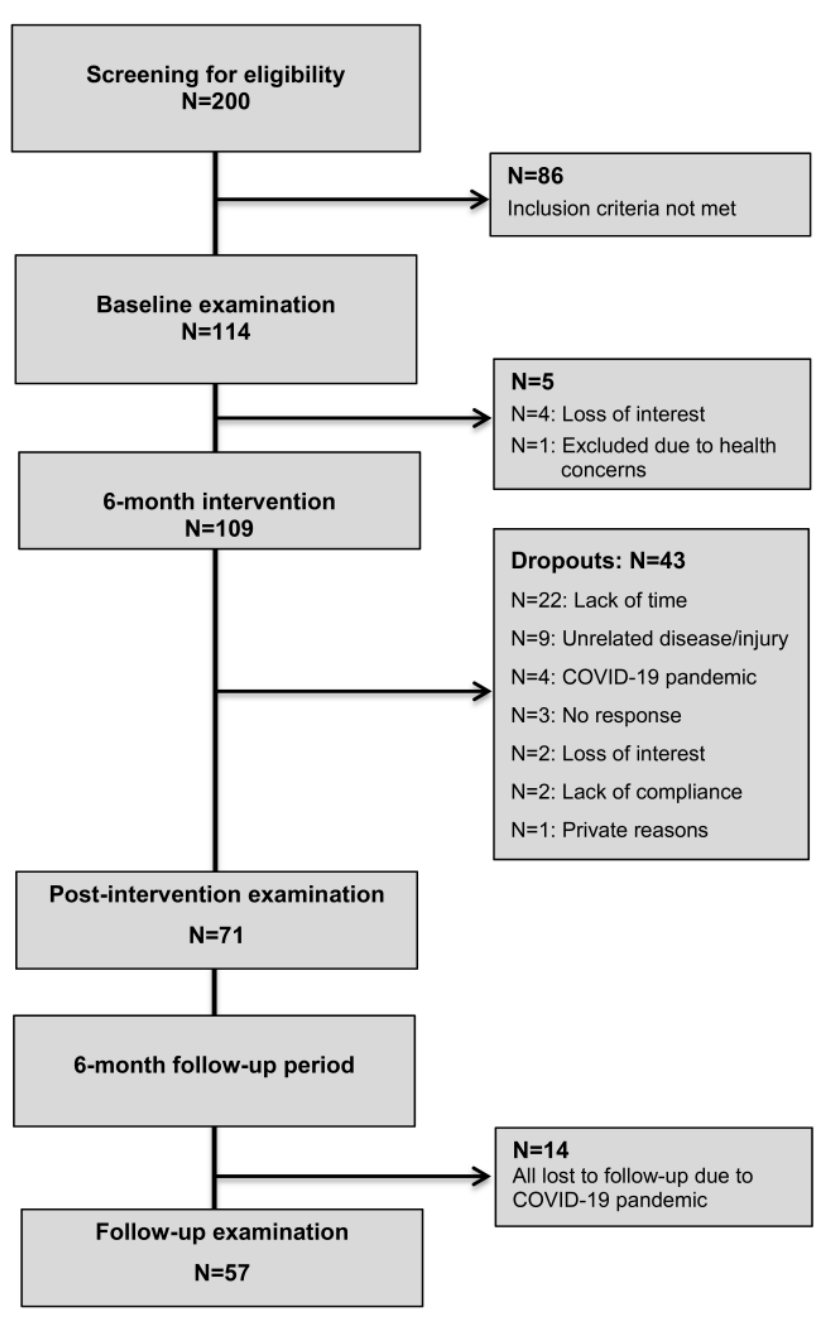
Figure 1. Study flow chart. Table 1. Mean values and standard deviations (SD) of participants’ (N = 71) cardiorespiratory fitness data pre- (T-1) and post-intervention (T-2).